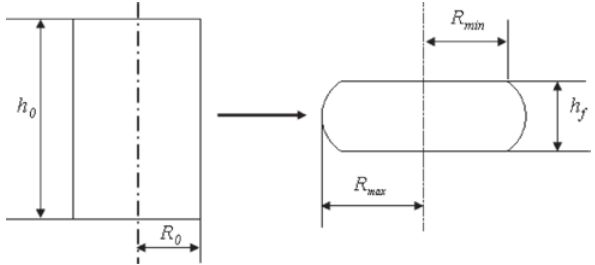
Fig. 2: Schematic diagram of a cylindrical specimen deformed in